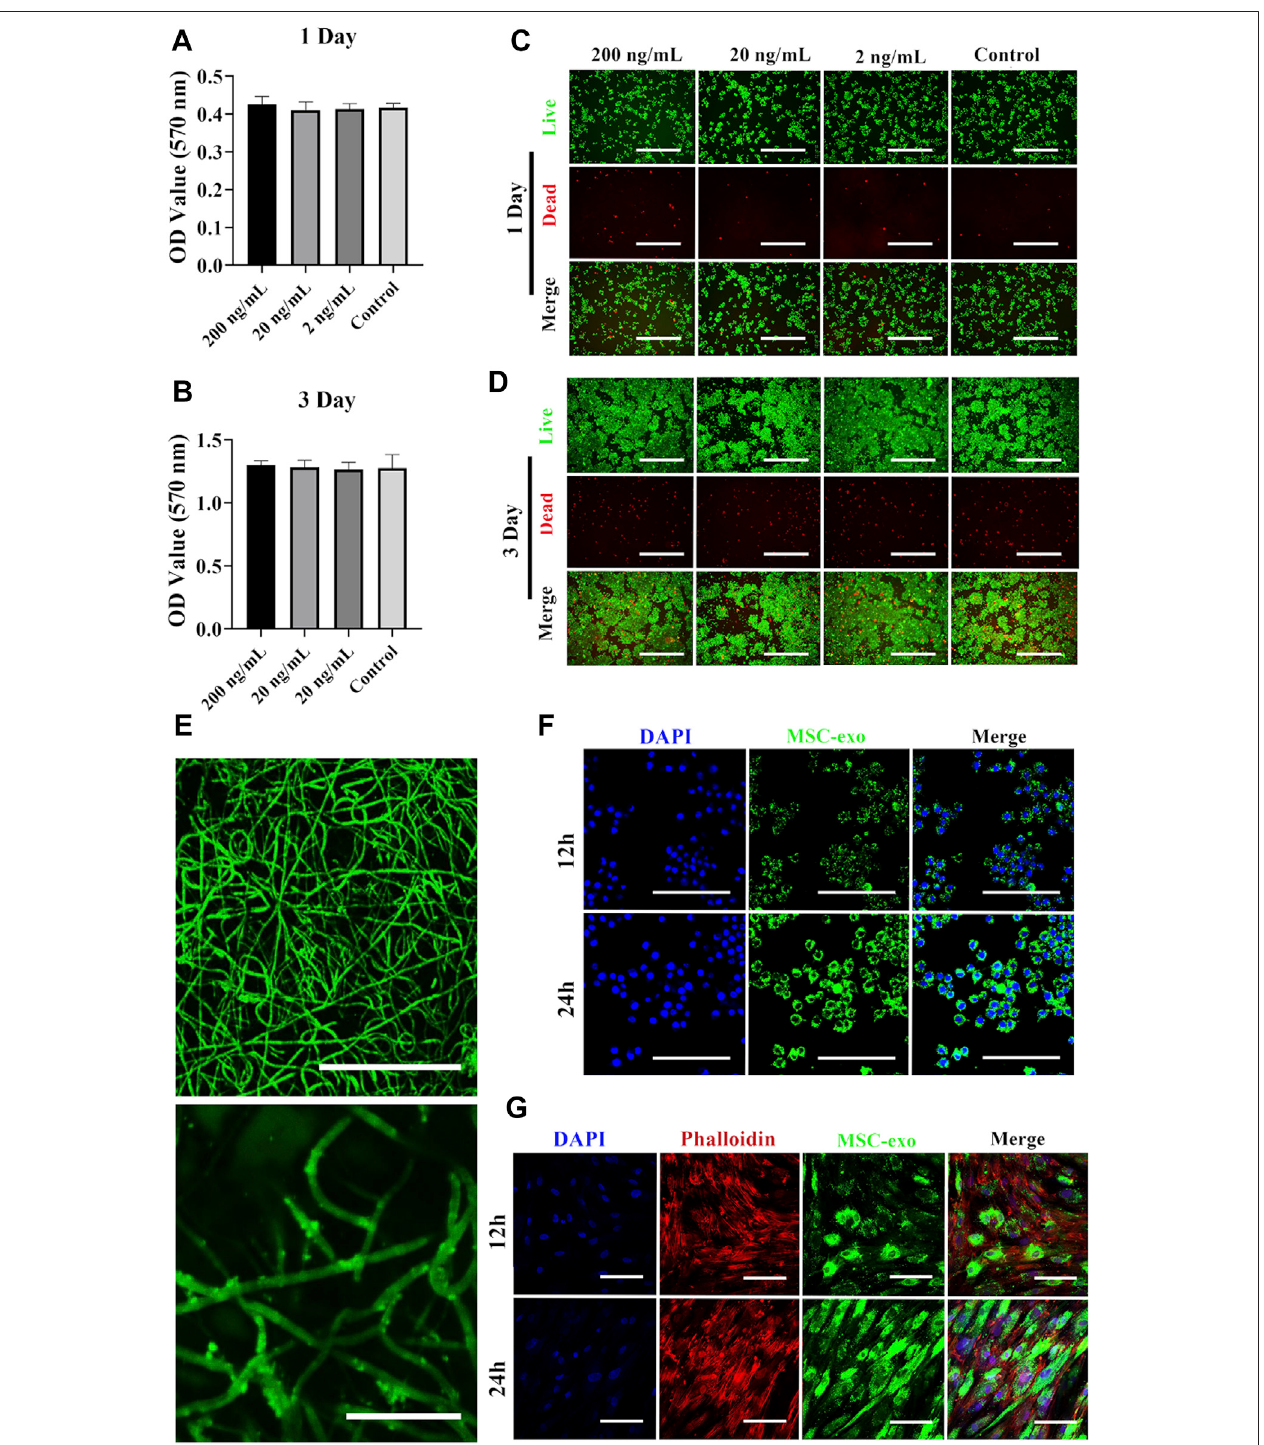
FIGURE2| SurfacecharacterizationoftheexosomeandAghybridscaffold. (A , B) MetabolicactivityofmacrophagesassessedbytheMTTassay.RAW264.7cells wereseededatadensityof5 × 10 3 /wellovernightat37 ° C.CellproliferationinthepresenceorabsenceofAgwasevaluatedbytheMTTassayat1and3days.Errorbars denote the mean ± SD ( n (cid:2) 5). (C , D) Live and dead assay of macrophages. RAW264.7 cells were seeded at a density of 5 × 10 3 /well overnight at 37 ° C. After Ag treatment, the cells were stained with FDA (live/green) and PI (dead/red) and were examined by confocal microscopy. Scale bars (cid:2) 200 μ m. (E) Representative confocal microscopy images of the exosome and Ag hybrid scaffold. Exosomes were prelabeled with PKH67 exosome staining solution. Scale bars (cid:2) 100 μ m (top panel). Scale bars (cid:2) 20 μ m (bottom panel). (F) Exosome released from the MSC-exosome and Ag hybrid scaffold was uptake by macrophages. Scale bars (cid:2) 100 μ m. (G) Exosome released from the MSC-exosome and Ag hybrid scaffold was uptake by hBMSCs. Scale bars (cid:2) 100 μ m. Effect of the exosome and Ag hybrid scaffold on macrophages.